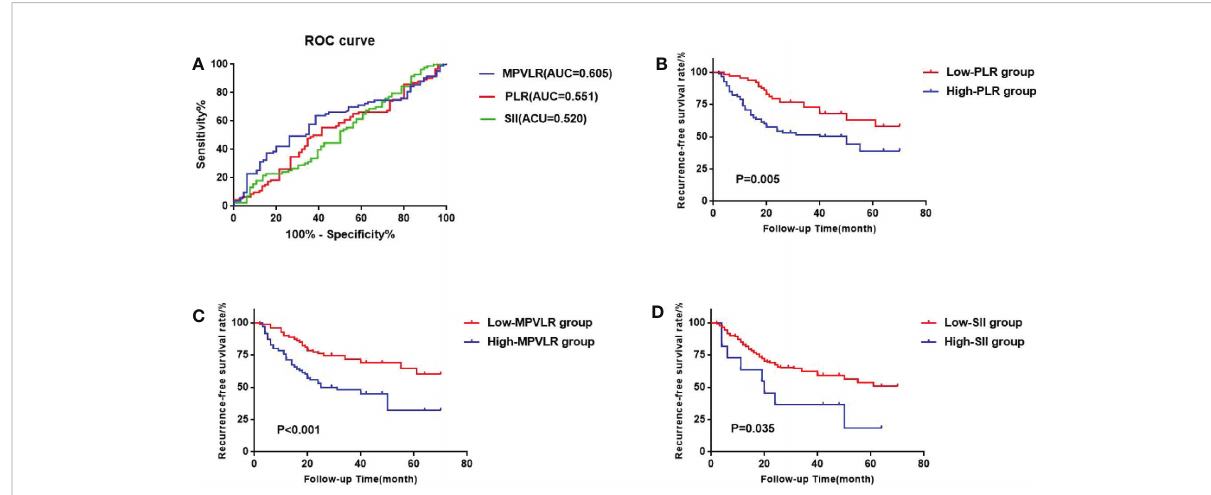
FIGURE 2 (A) the receiver operating characteristic (ROC) curves of the best cutoff values of platelet-to-lymphocyte ratio (PLR) PLR, mean platelet volume to lymphocyte ratio (MPVLR), and systemic immune in fl ammatory index (SII) of the GEM group. (B) Comparison of sur-vival curves between the high PLR group and the low PLR group. (C) Comparison of survival curves between the high MPVLR group and the low MPVLR group. (D) Comparison of survival curves between the high SII group and the low SII